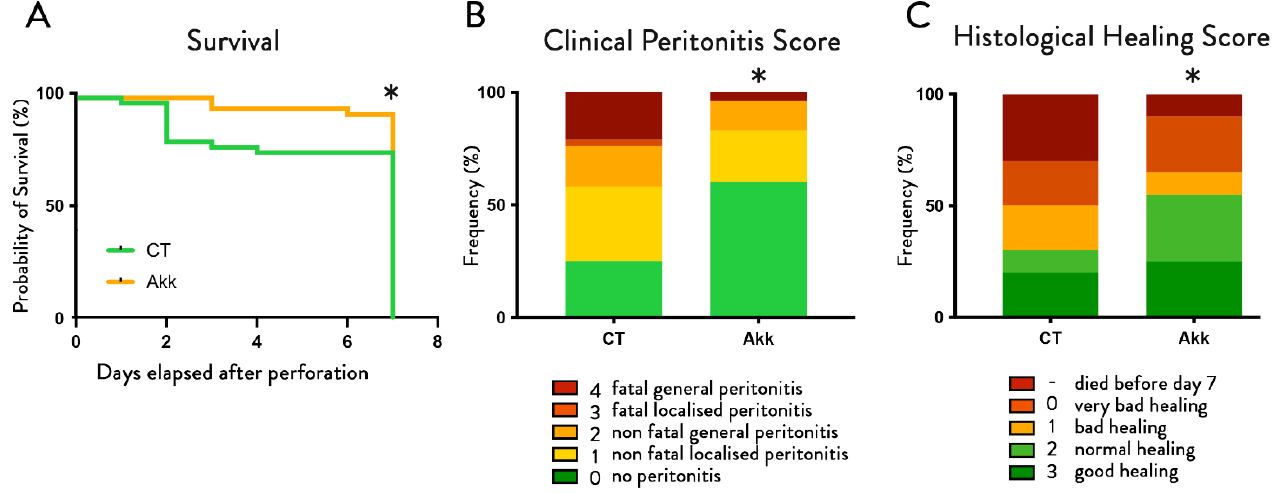
Figure 2. A. muciniphila administration reduces mortality and peritonitis severity and improves healing score . Effect of A. muciniphila administration on ( A ) survival ( n = 40 per group) and ( B ) peritonitis severity ( n = 40 per group) and ( C ) healing score ( n = 20 per group) in a colonoscopic leakage model. Survival p -value = 0.0224 Gehan–Breslow–Wilcoxon test, clinical peritonitis score * * corresponds to the statistics: p -value < 0.0001, and histological healing score p -value < 0.0001 Chi- square test.